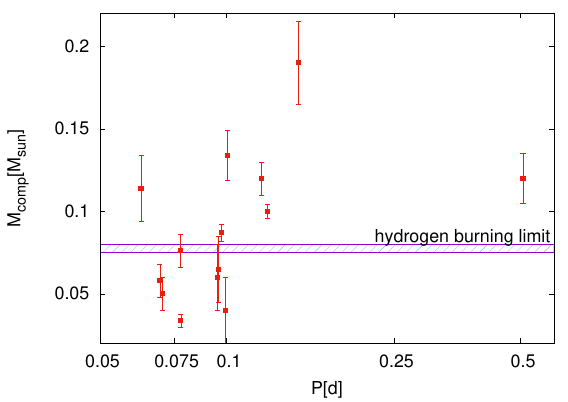
Figure 6. Preliminary period-companion mass diagram of the OGLE HW Vir systems with radial velocity curves.